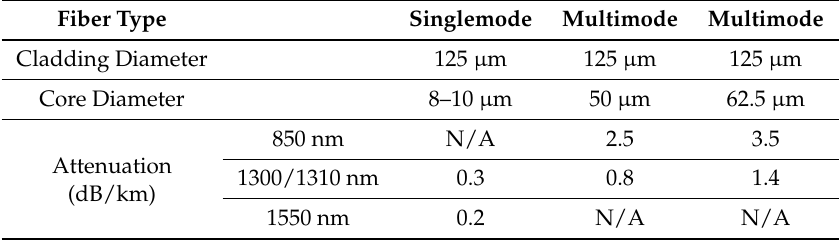
Table 1. Attenuation loss of different types of optical fiber. (Adapted from [13].)